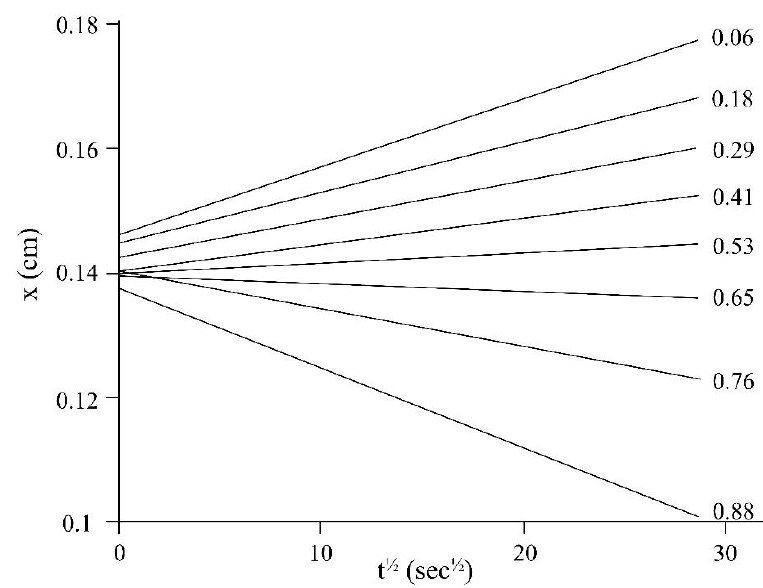
Figure 4. Typical kinetic dependences of the iso-concentration planes movement in the interdiffusion zone. The numbers indicate values of the mass fraction of DER-331.